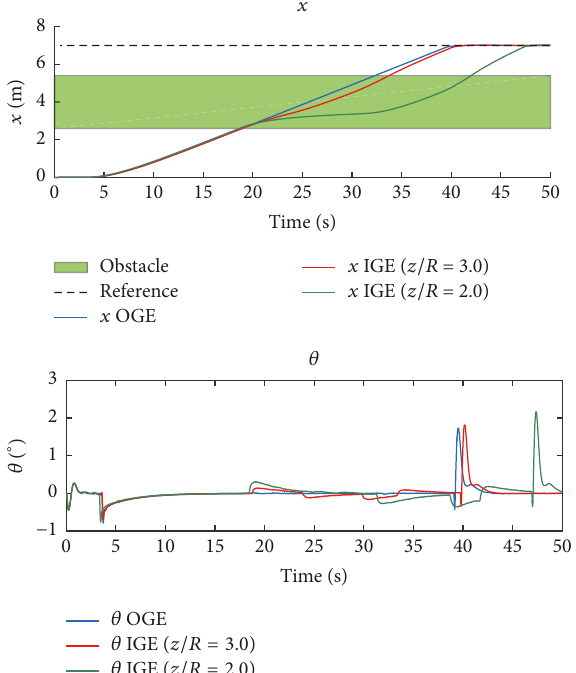
Figure 17: Estimated torque controller: flying over an obstacle.